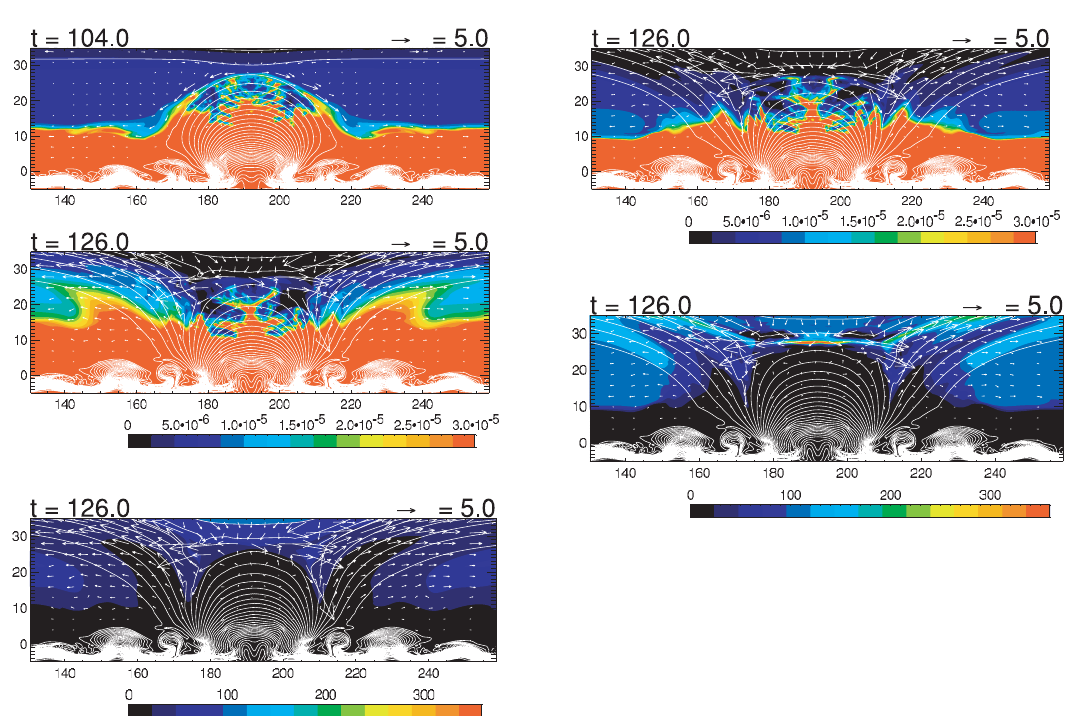
Figure 54: Left: 2D simulations of emerging flux with pre-existing horizontal coronal field including the anisotropic thermal conduction. Top and middle panels show density distribution (color), magnetic field lines, and velocity field. The color in the bottom panes shows temperature distribution. Two evaporation jets are seen in the both side of the emerging loop as dense ejecting structure with coronal tempera- ture. Right: same simulation but without thermal conduction. Image reproduced with permission from Miyagoshi and Yokoyama (2003), copyright by